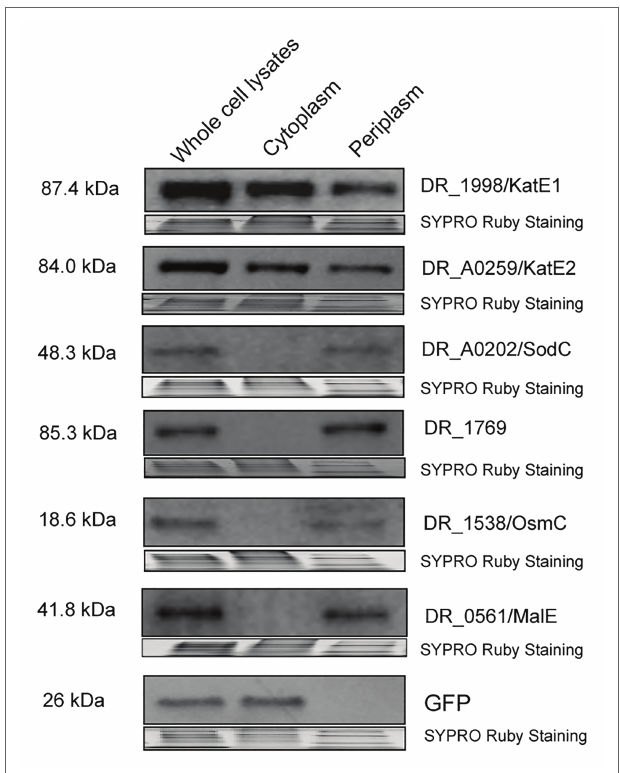
FIGURE 5 | Western blot showing DR_1998/KatE1, DR_A0259/KatE2, DR_A0202/SodC, DR_1769, and DR_1538/OsmC proteins detected in the whole cell lysates, cytoplasm, or periplasm of R1. GFP (expressed off the pRADgro plasmid) and DR_0561/MalE (periplasmic maltose binding protein) were used as marker proteins in the cytoplasm and periplasm, respectively. Molecular weights are indicated in kDa on the left of each blot. SYPRO Ruby staining served as a loading control to indicate that the protein amount loaded in each lane is